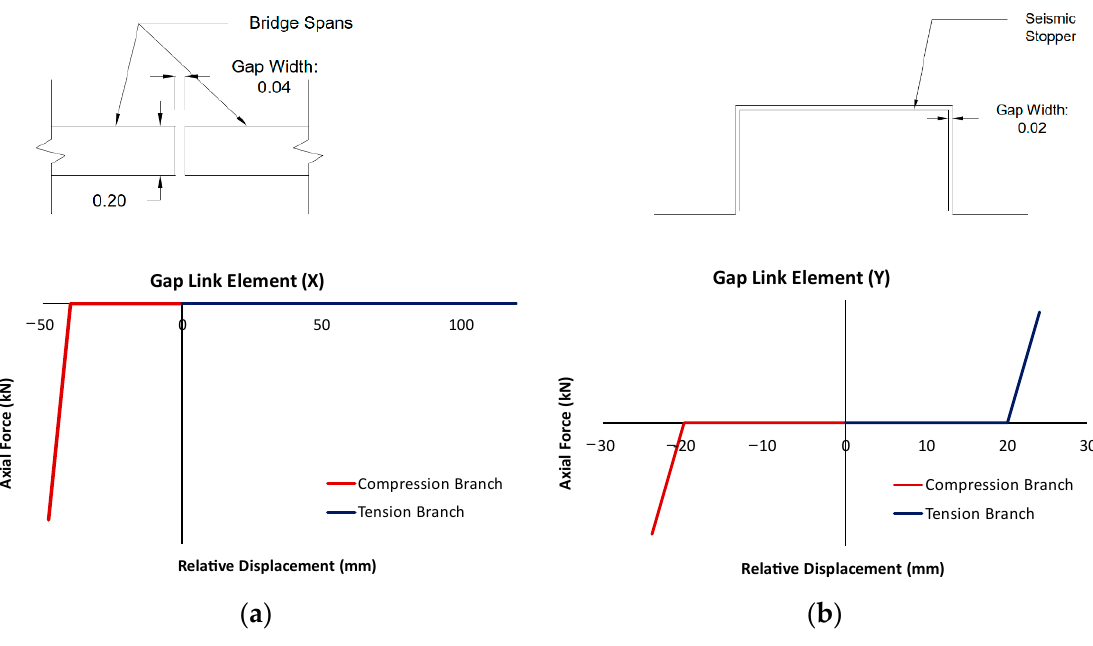
Figure 10. Gap properties: ( a ) expansion joint in the longitudinal direction and ( b ) stopper in the transverse direction.